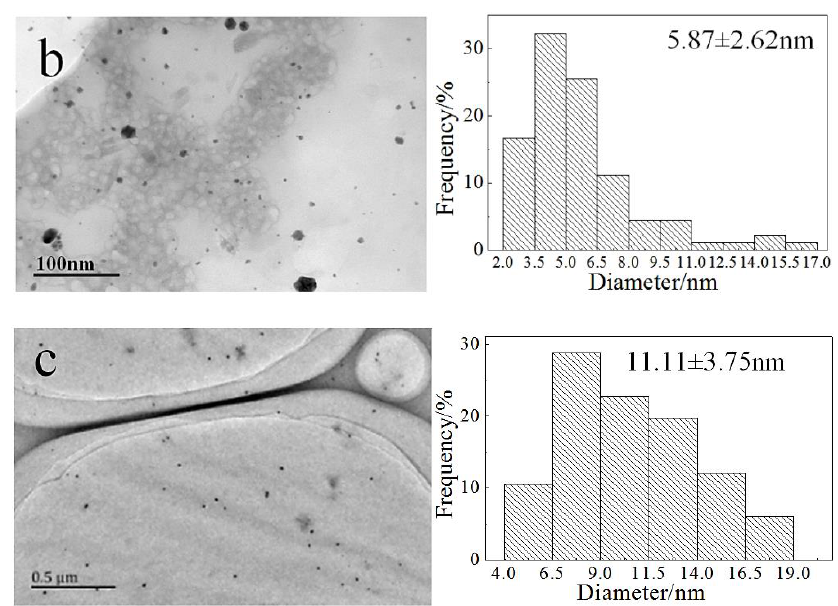
Figure 2. Characterization and size distribution of AuNPs dispersed in the inner membrane organic matrix framework. The concentrations of HAuCl 4 in a, b, and c are 5 × 10 −5 , 1 × 10 −4 , and 1.5 × 10 −4 mol/L, respectively.